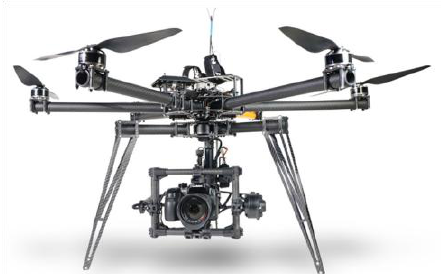
Figure 5. Hexakopter CineStar 6 HL (© copterproject